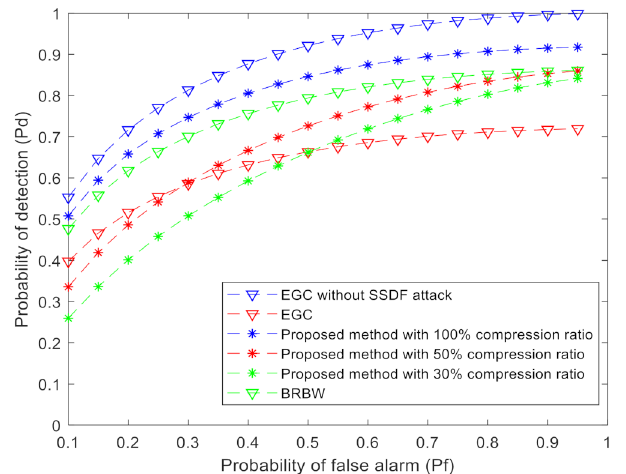
Figure 13. Comparison of spectrum sensing performance under different compression ratio (SNR = 4, MUs no. = 5, probability of SSDF attack =